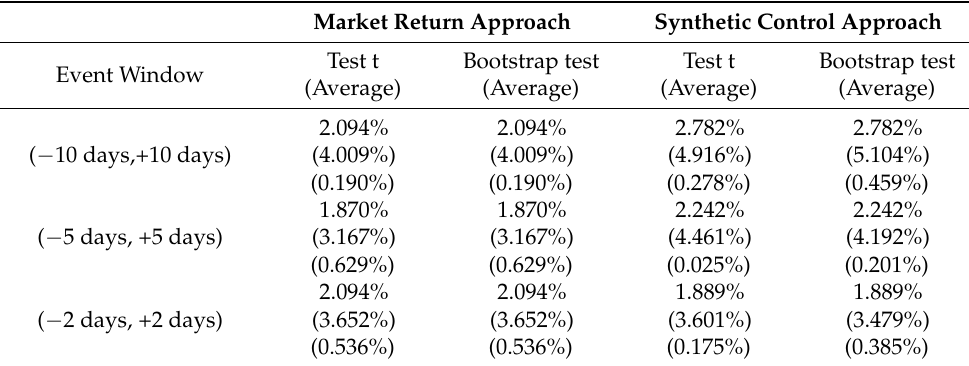
Table 2. Significance test on the sample of cumulative average abnormal return, according to the event windows 1 . Market Return Approach Synthetic Control